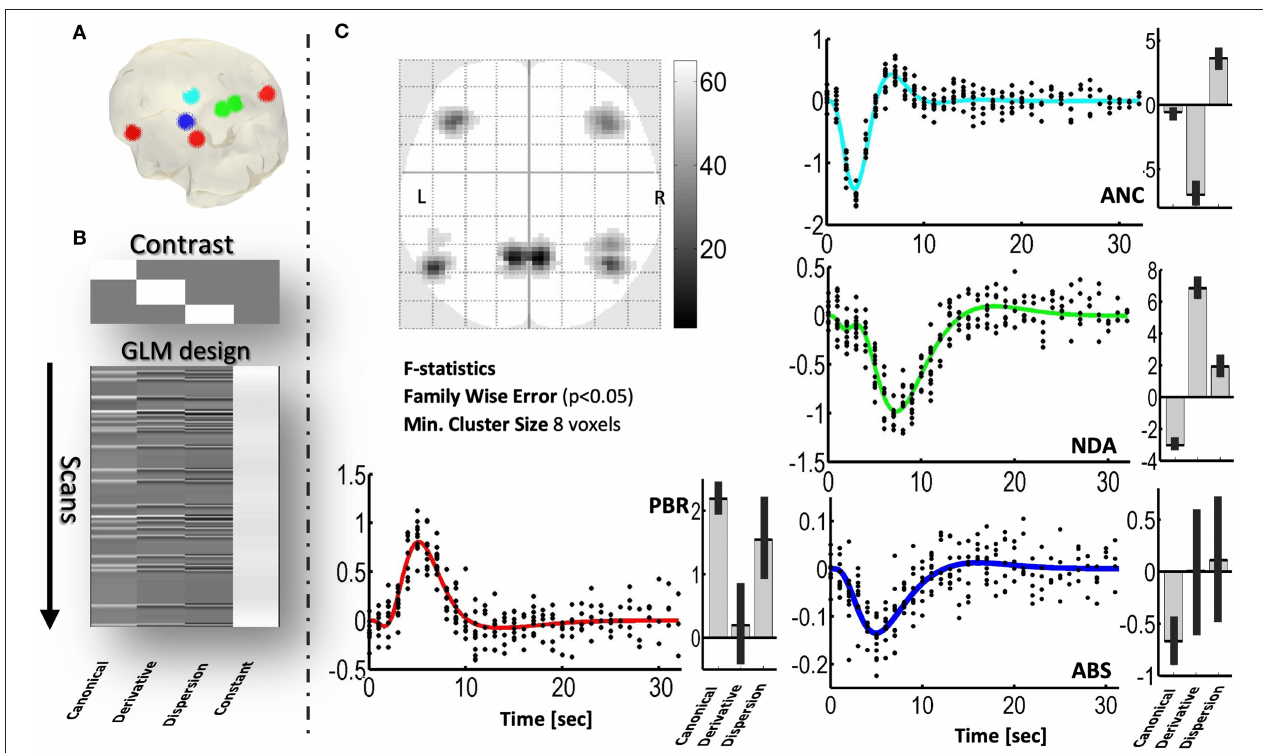
FIGURE 2 | Detection, using the GLM, of simulated spatial distribution of PBRs and three NBRs in a realistic sequence of echoplanar fMRI scans. (A) Three- dimensional glass brain showing the regions where the mechanisms were simulated. (B) F contrast (the 3-order identity matrix) and design matrix of the GLM, used to detect significant voxels. (C) Two-dimensional glass brain showing the F statistics. The plots show the responses predicted by the GLM (color curves) and the adjusted data (black dots), for each mechanism. Besides each plot, the estimated values and confidence intervals of the coefficients, β can , β der , and β disp , of the GLM are shown. PBR (red), NDA (green), ANC (cyan), ABS (blue).